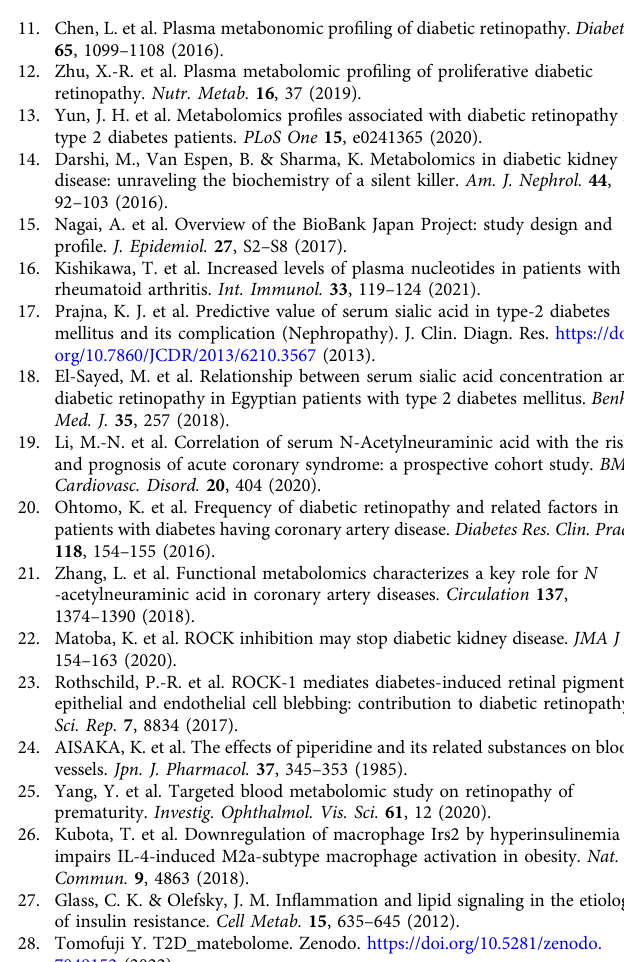
Fig. 3 Results of the metabolite set enrichment analysis. a A quantile – quantile plot of the p values of pathways in MSEA based on the KEGG pathways. The x -axis indicates log-transformed expected p values. The y -axis indicates log-transformed observed p values. The diagonal dashed line represents y = x , which corresponds to the null hypothesis. The horizontal red dashed line indicates the Bonferroni-corrected threshold ( α = 0.05), and the brown dashed line indicates the FDR threshold (FDR = 0.10) calculated with the Benjamini-Hochberg method. Pathways with p values less than the FDR thresholds are plotted as brown dots. b Bar-plot of the Z-scores in case – control association tests. The x -axis indicates the rank of the metabolites according to their Z-score. the y -axis indicates the Z-scores of the metabolites. Rhombus indicates the metabolites which are annotated as fatty acid biosynthesis-related metabolites. The number of samples used for the analysis is N DR + DKD = 141 and N control = 159. DKD, diabetic kidney disease; DR diabetic retinopathy; ES, enrichment score; FDR, false discovery rate; KEGG, Kyoto Encyclopedia of Genes and Genomes; MSEA, metabolite set enrichment